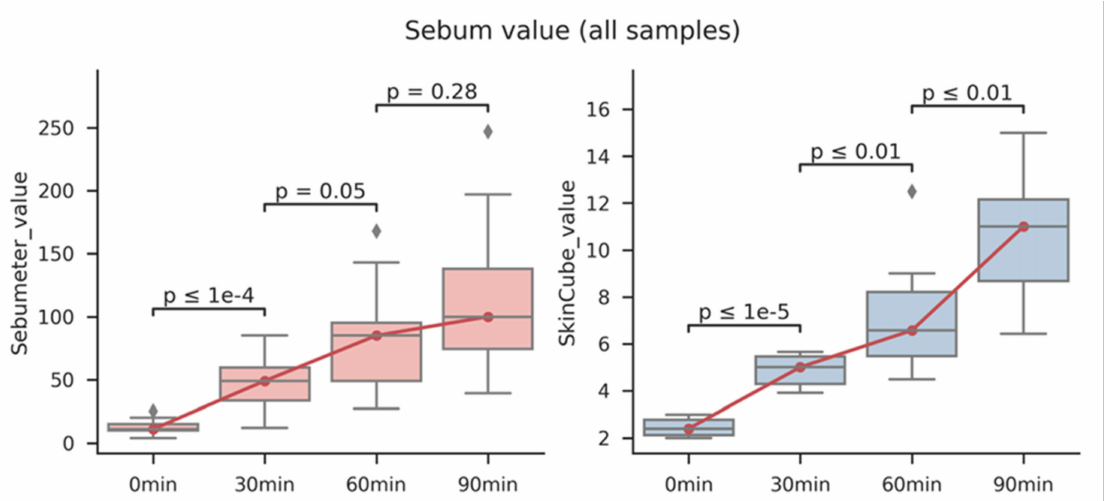
Figure 3. Comparison of Sebumeter ® and fabricated system using color sensor to detect skin casual sebum on sebum replacement time. Facial skin sebum of five participants was measured by sebum replacement time and compared using a Sebumeter ® and a fabricated system, respectively.